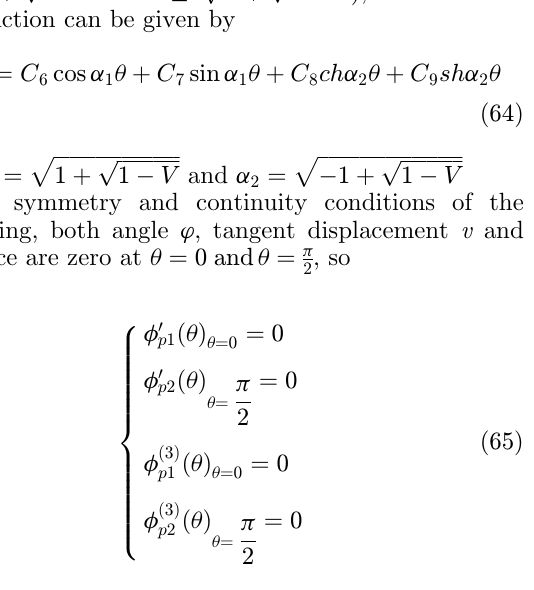
ffiffiffiffiffiffiffiffiffiffiffiffi p p 1 þ 1 (cid:1) V